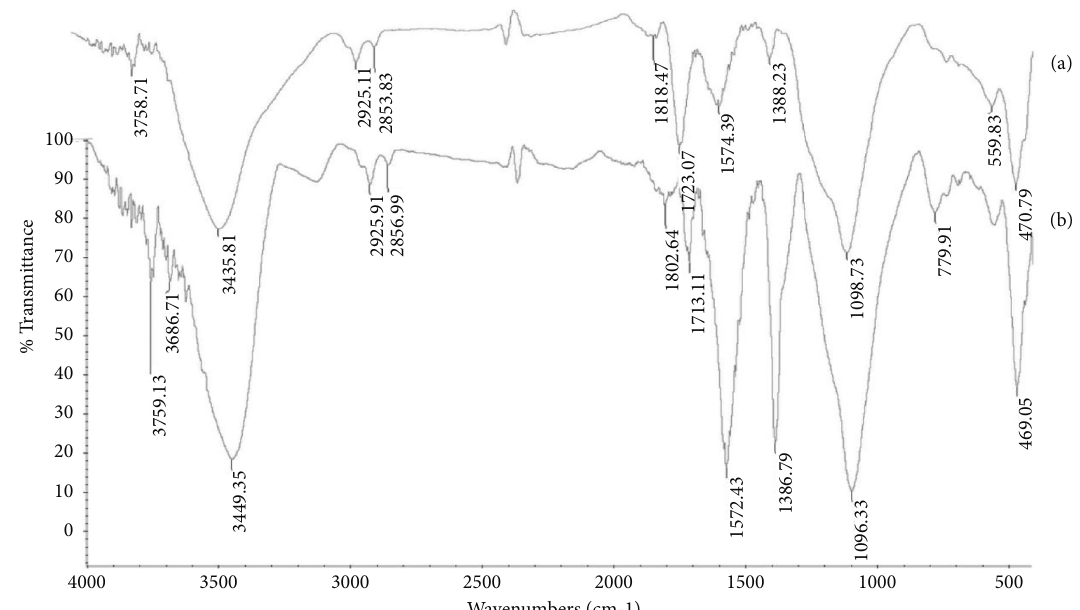
Figure 3: FT-IR spectra of GO (a) and GO/Al of Al 2 O 3 (Figure 4).